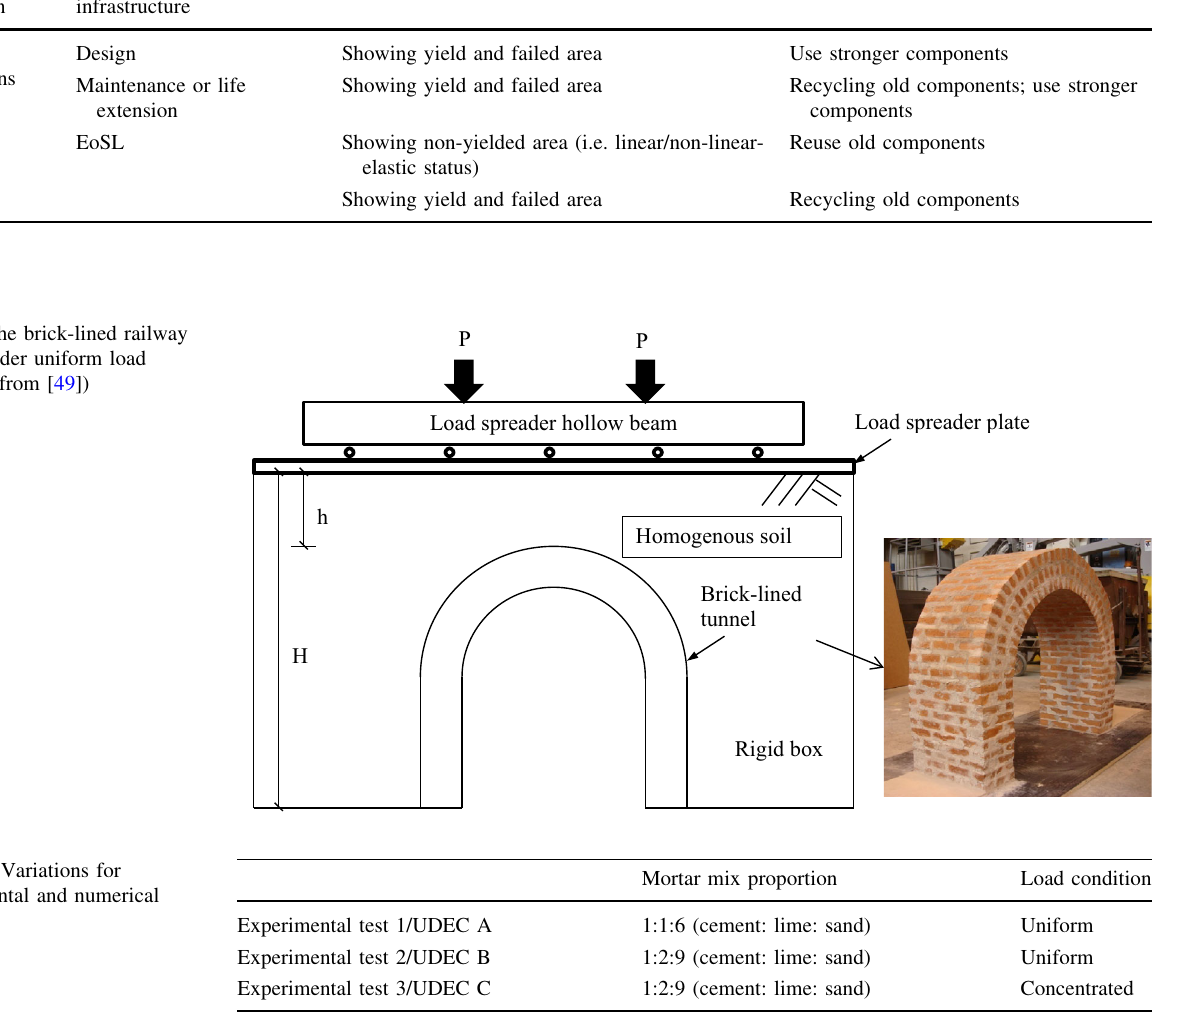
Table 2 Summary of numerical predictions to guide circular approaches for underground infrastructures Required Prediction